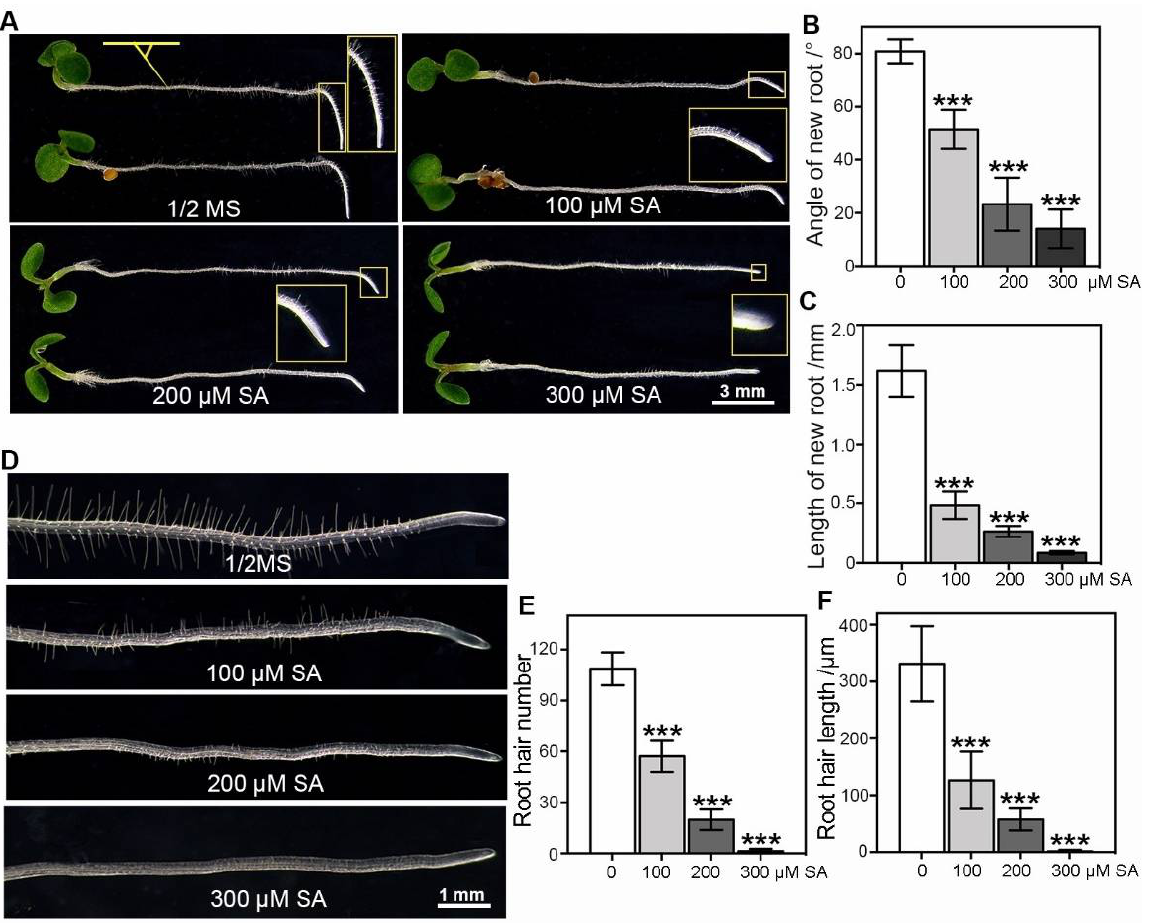
Figure 1. Effects of high-concentration SA on root gravitropic responses and root hair development in Arabidopsis . Five-day-old wild-type Arabidopsis (Col-0) seedlings grown on 1 / 2 MS medium were used. ( A – C ) Effects of SA treatments on the deviated root tip angles and new root growth. Five-day-old seedlings were transferred to new 1 / 2 MS medium plates supplemented with 100, 200 or 300 µ M SA, and cultured for another 16 h after being orientated at 90 ◦ . The inset images show 1.5, 2.0, 3.0, and 4.5 × enlarged new root growth, respectively. Scale bar = 3 mm. ( D – F ) Effects of SA treatments on root hair development. Five-day-old seedlings transferred to new 1 / 2 MS medium plates supplemented with 100, 200 or 300 µ M SA were vertically cultured for another 48 h. Root hair number and length were measured (n = 6). Scale bar = 1 mm. Student’s t -test was performed between the groups (mock vs. SA). Error bar = standard deviation (SD). p -values were determined with two-tailed Student’s t -test assuming equal variances (*** p < 0.001).